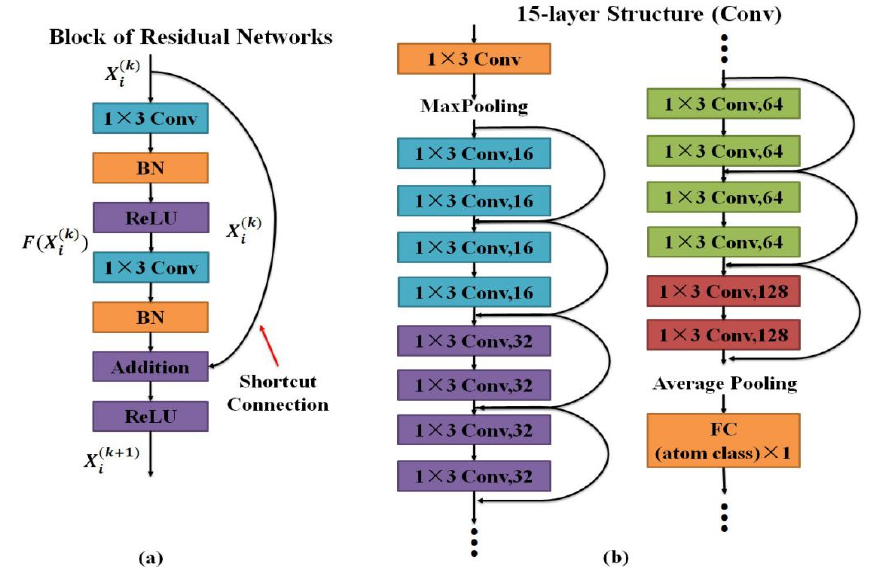
Figure 2. Network architectures for our encoder: ( a ) a block of residual networks, ( b ) main structure of